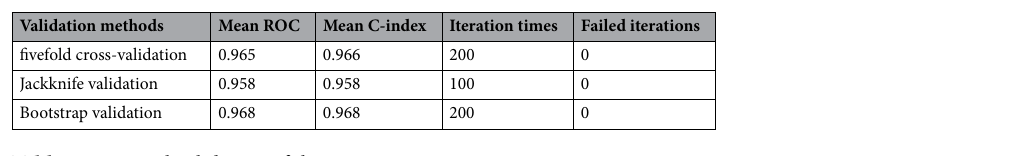
Table 7. Internal validation of the